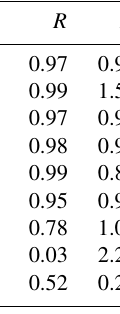
Figure 1. Setups for LA-ICP-MS of rotated ( a , sample 1, stages 7– 10) and non-rotated ( b , sample 3, stages 6–9) filters; both opti-